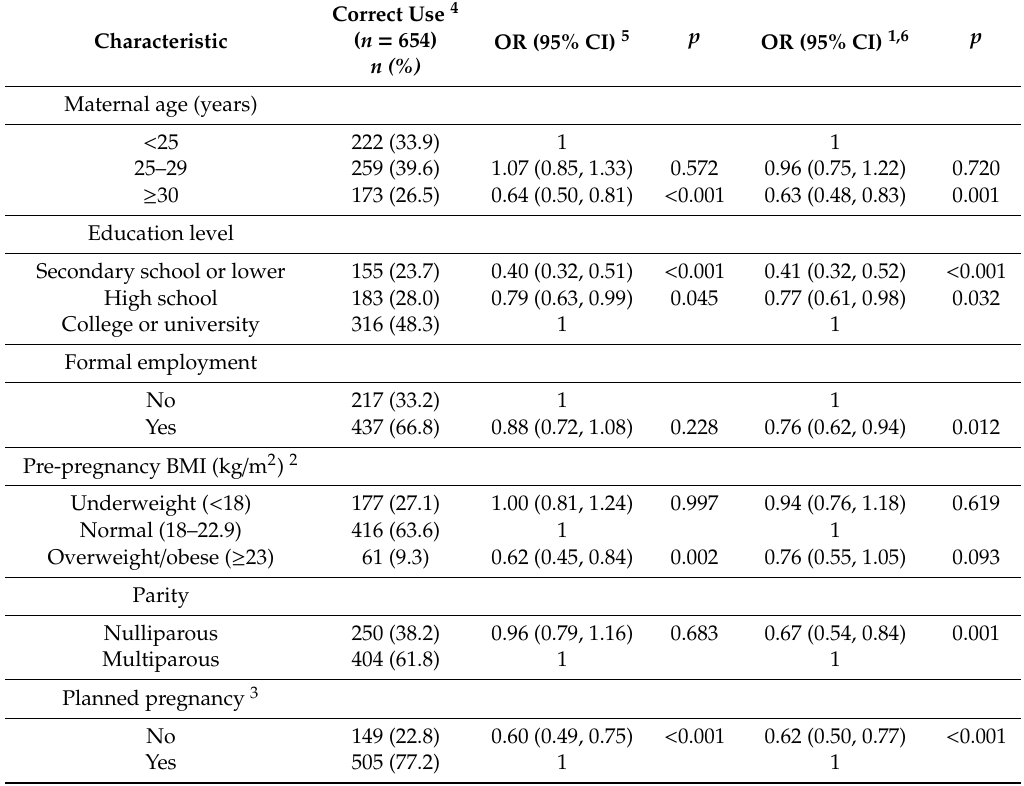
Table 3. Maternal characteristics associated with the correct use of either supplements containing folic acid alone or multivitamins containing folic acid during the periconceptional period in